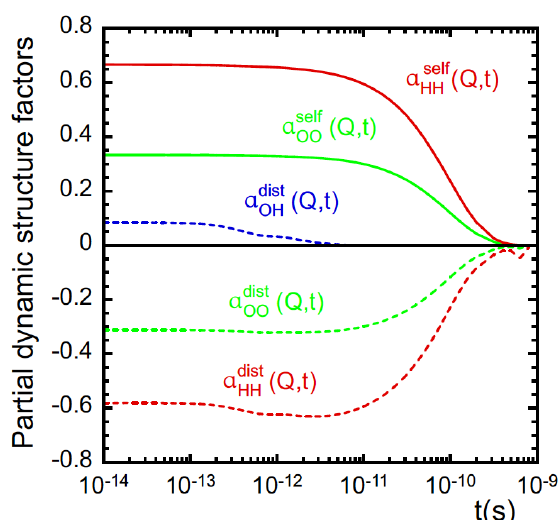
Fig. 3. Self and distinct contributions to the partial dynamic structure factors 𝑎 BC (𝑄,𝑡) ( 𝛼,𝛽 ∈ {H,O} ) calculated from the simulations for Q = 0.2 Å 34 : 𝑎 nnrstu (0.2,𝑡);𝑎 nnv‘rh (0.2,𝑡); rstu (0.2,𝑡); 𝑎 v‘rh (0.2,𝑡) and 𝑎 v‘rh (0.2,𝑡) . Hatched area 𝑎 pp np pp indicates the diffusion range.